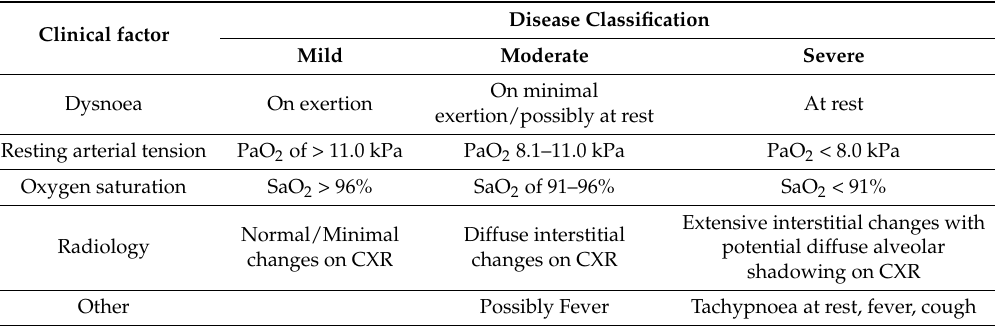
Table 2. Classification of Pneumocystis pneumonia